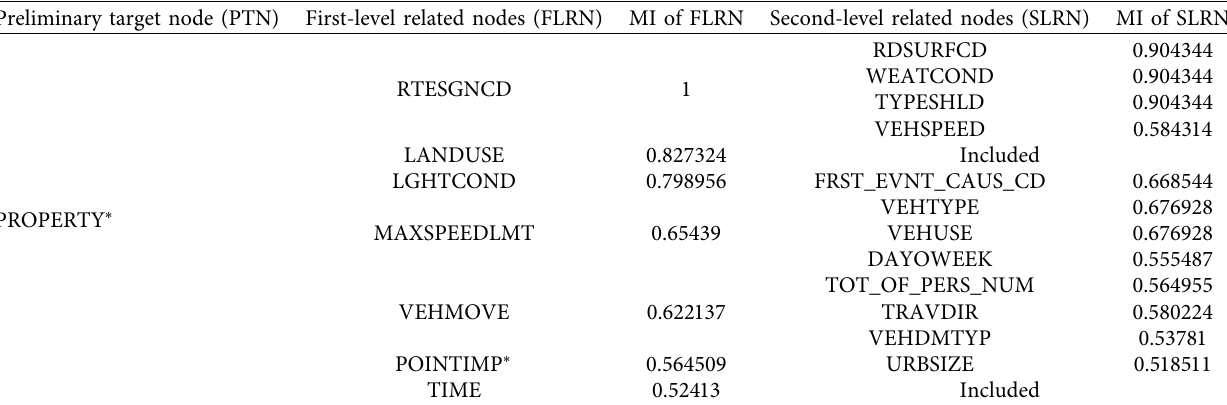
Table 2: Node fltering process associated with the preliminary target node (PROPERTY).